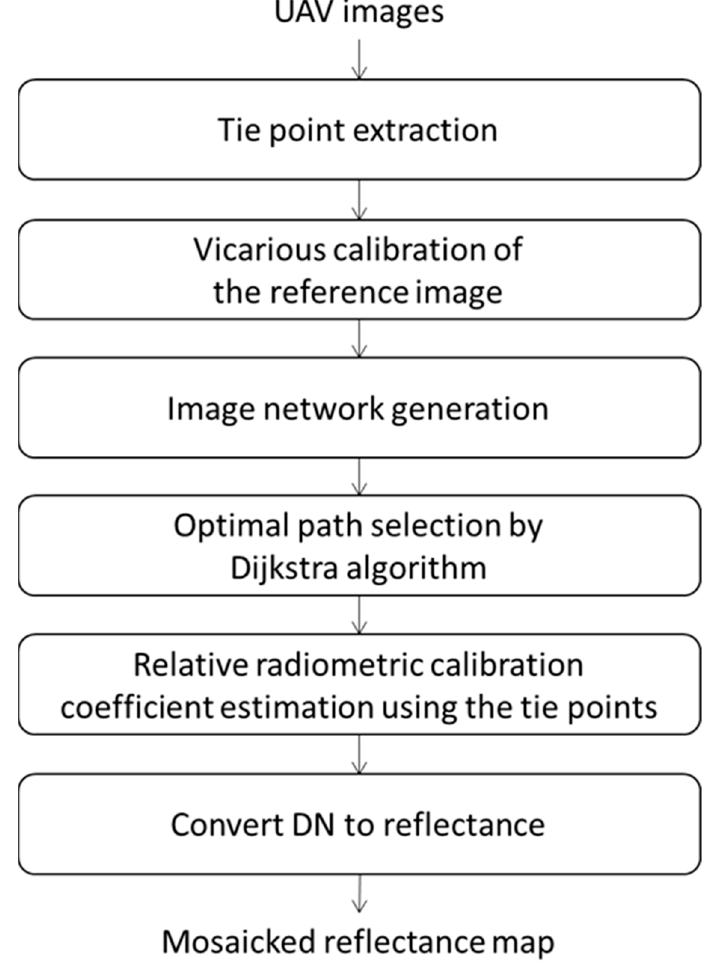
Figure 5. Overall procedure for radiometric calibration of UAV images.